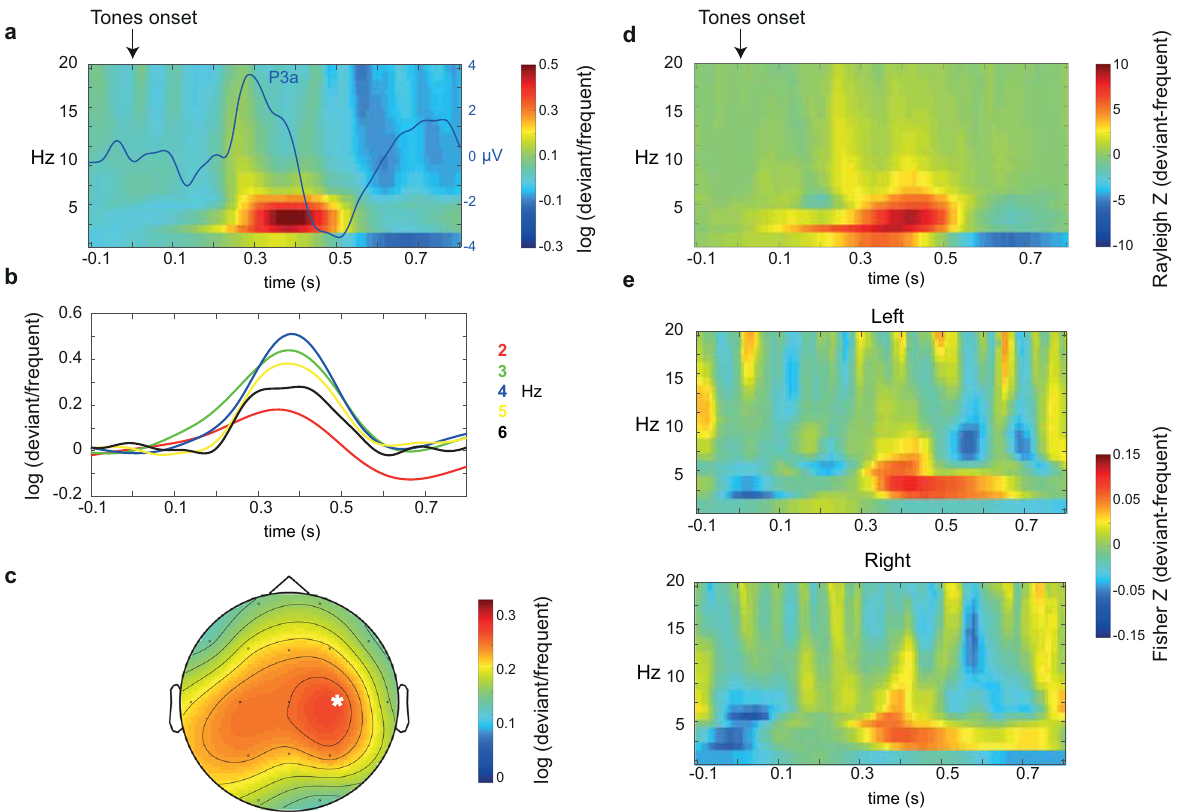
Fig. 3 Time-frequency windows of interest across all participants. a TFR of power difference between deviant and frequent tones, showing modulation of theta oscillations. The P3a ERP (deviant-frequent) is shown superimposed, with voltage scale at the right y axis. b Maximal differences of power were found at 4 Hz. c Maximal theta (4 Hz) difference in power was found at right central regions (C4, marked with an asterisk). d TFR of phase alignment (PLF) difference between tones, with similar results to TFR of power. e TFR of fronto-parietal connectivity difference between deviant and frequent tones. The upper panel shows the left pair (F7-P7) and the lower panel shows the right pair